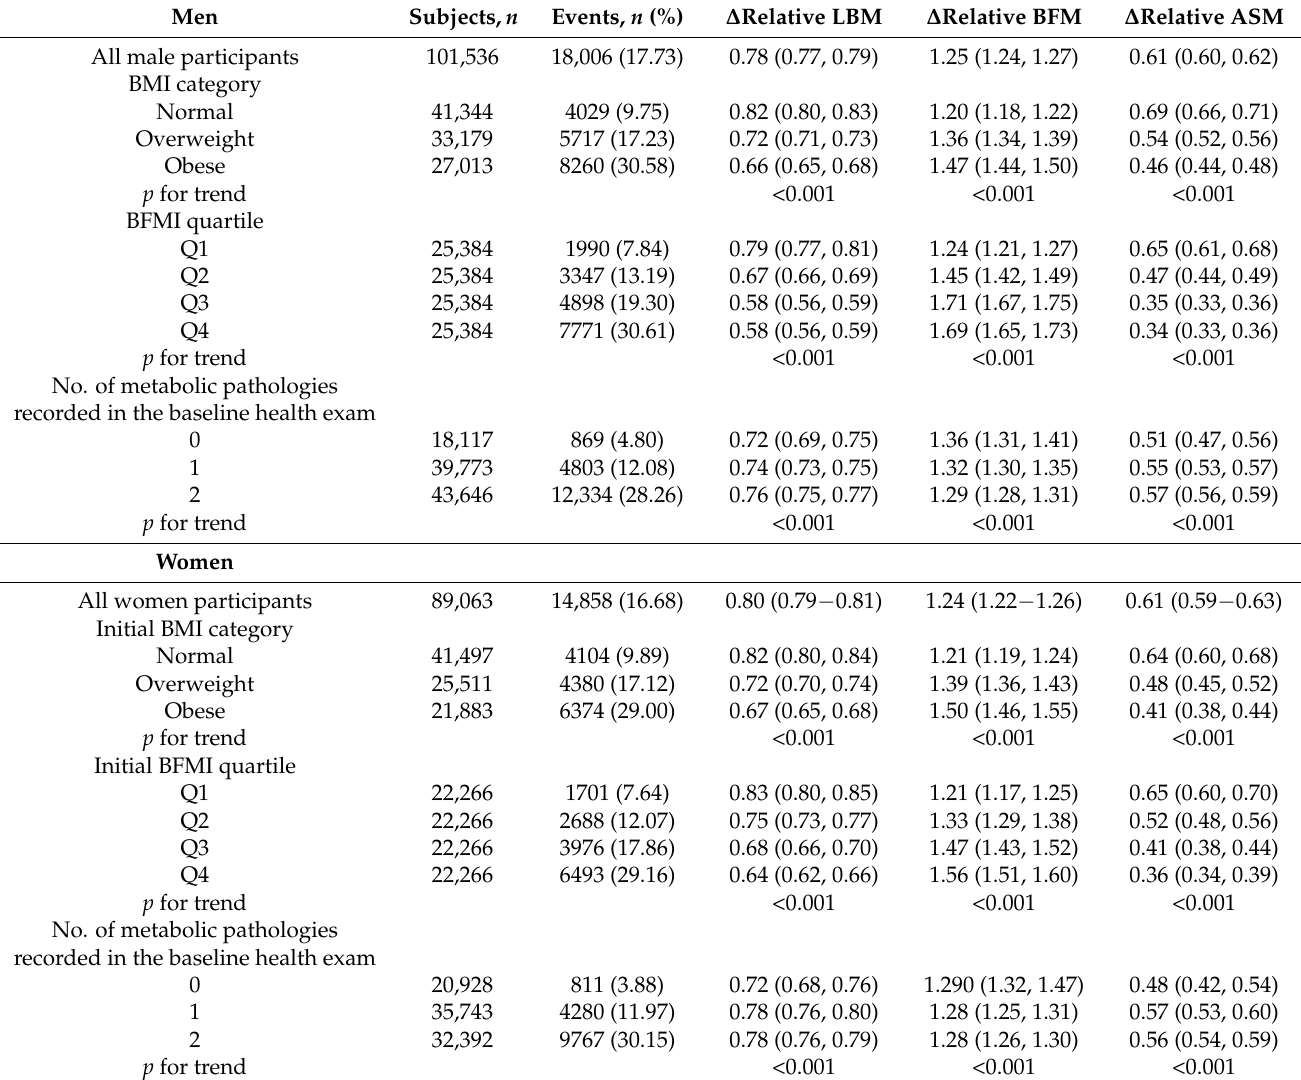
Table 3. Adjusted odds ratios and 95% confidence intervals of metabolic syndrome according to the changes (1% increments) in multiple body composition parameters in the